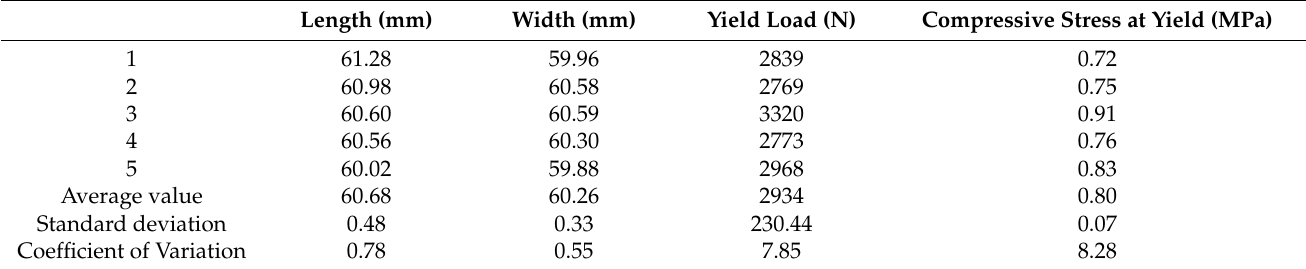
Table 5. Data of sample group A.